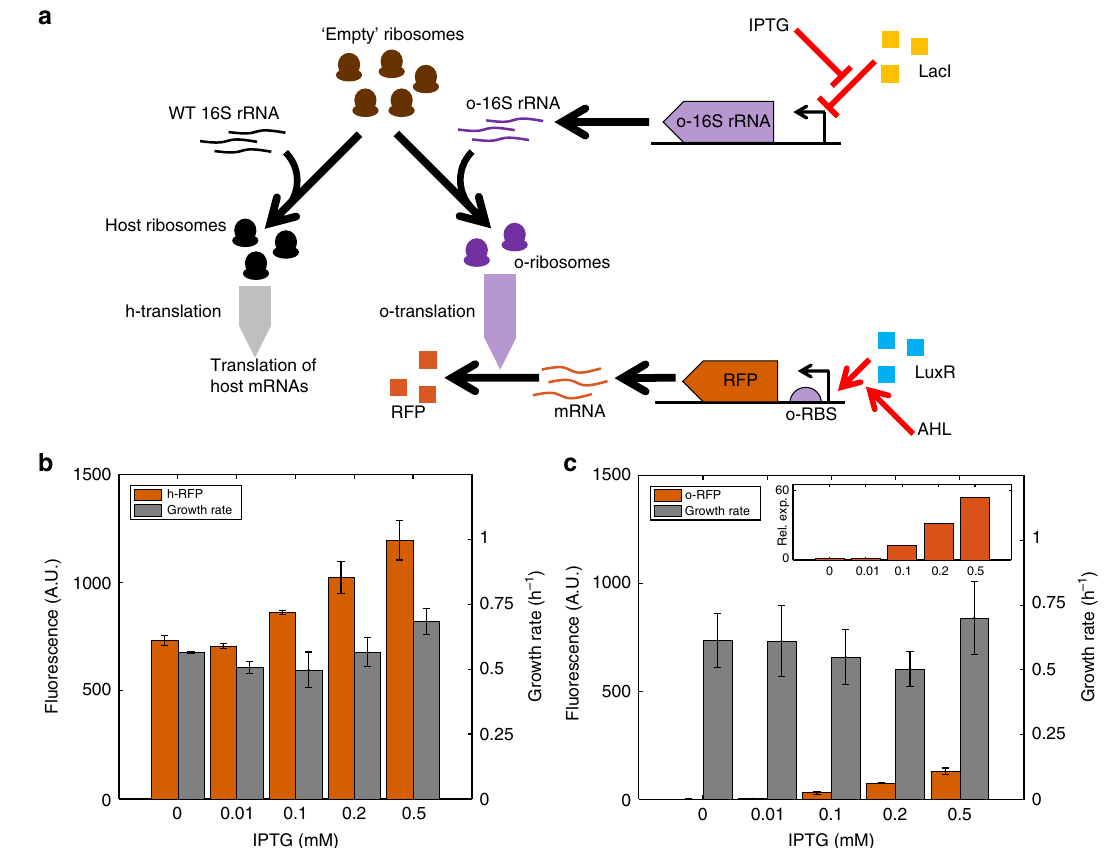
Fig. 1 Developing the o-ribosome pool as an expression system. RFP expression using either the host or o-ribosome pool. o-ribosomes are produced by inducing o-16S rRNA with increasing concentrations of IPTG. (o/h)-RFP is induced with 20 nM AHL throughout. Bars represent means ± 1 SD. N = 3. a Schematic of the orthogonal translation system. b Expression of h-RFP by the host ribosome pool. c Expression of o-RFP by the o-ribosome pool. Inset, relative o-RFP expression. RFP levels normalised by background. x -axis, IPTG concentration